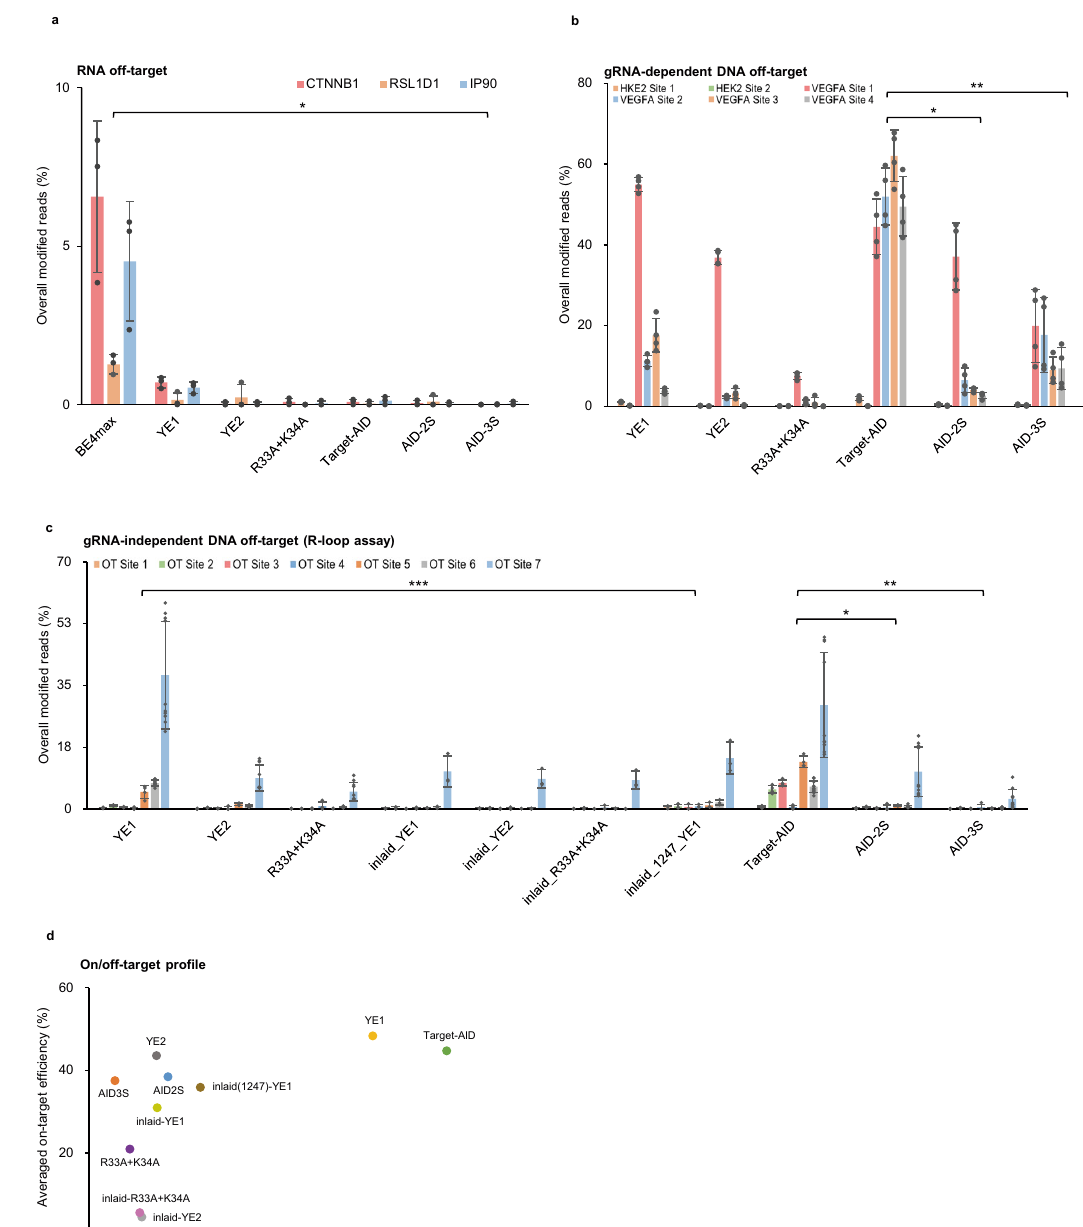
Fig. 3 | Off-target assessment of AID-2S, − 3S and rAPOBEC1 base editors. a Targeted RNA sequencing of three gRNA-independent locus reported before (CTNNB1, RSL1D1, and IP90) was performed for four rAPOBEC1 CBEs and three Target-AID CBEs. Data are presented as mean values±sd ( n =3). Statistically sig- ni fi cantdifferencesbetweenBE4maxandotherCBEsweresupportedbytwo-tailed unpaired Student ’ s t-test; p -value ( P* =1.98E-03~ 2.36E-03 for RSL1D1site, 1.45E-02 ~2.18E-02forIP90site,8.90E-03~1.33E-02forCTNNB1site).ThegRNA-dependent RNA off-target was also shown in Supplementary Fig. S7. b Evaluation of Cas9- dependent off-target effects. The two HEK2 off-target sites and four VEGFA off- target sites were analyzed by DNA amplicon deep sequencing. AID-2S, -3S showed signi fi